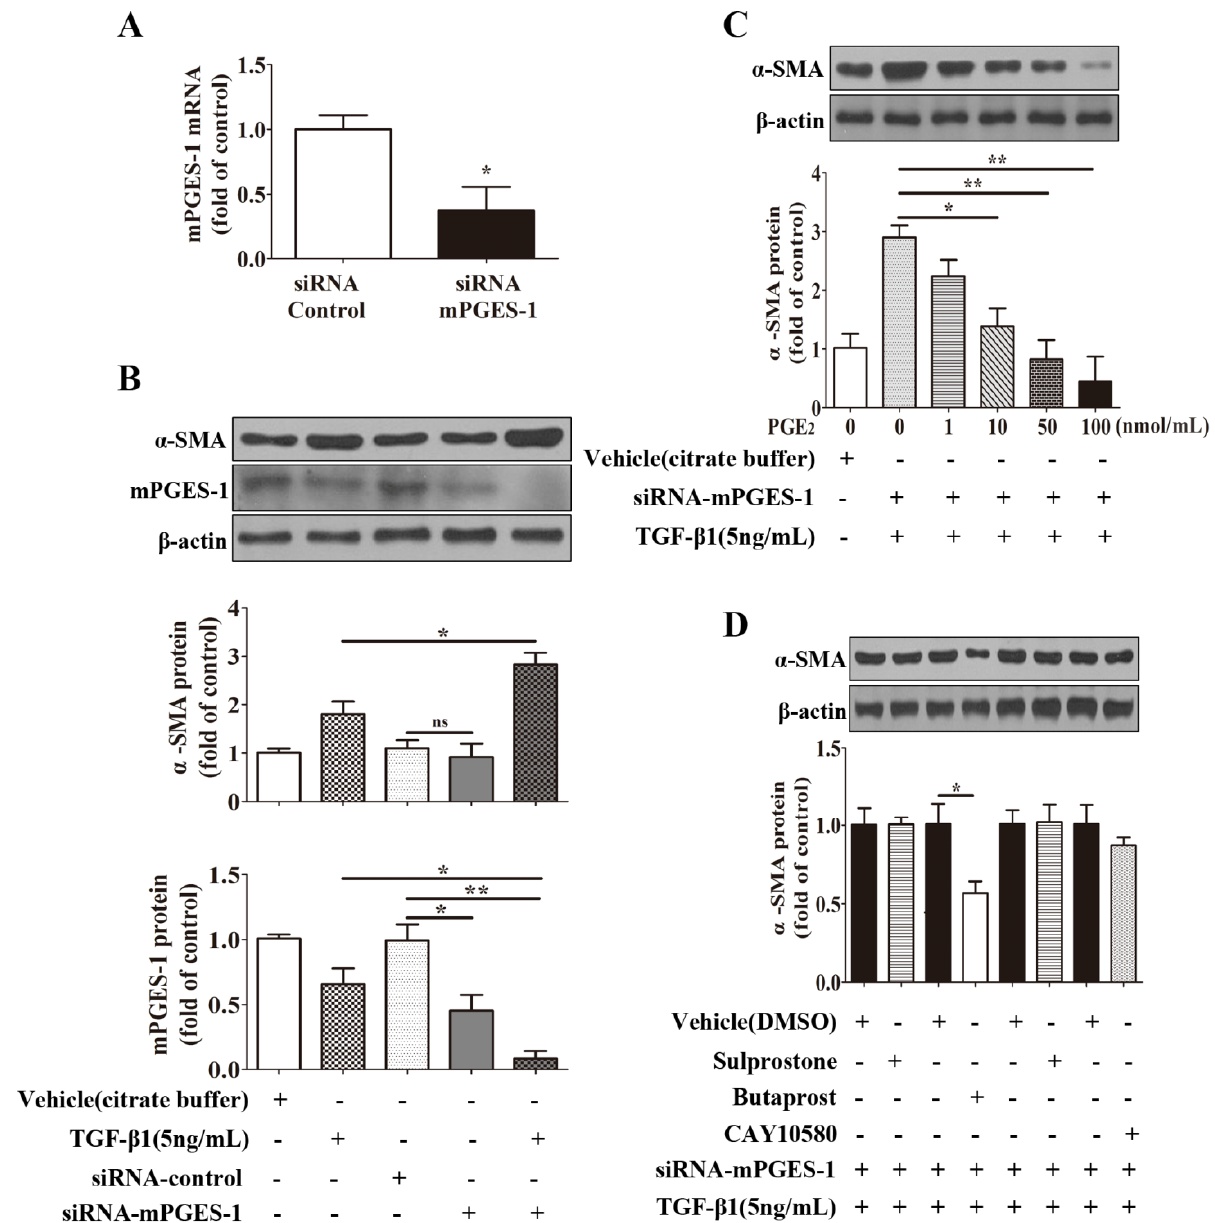
Figure 6. mPGES-1-derived PGE exerts a beneficial effect against α -SMA expression 2 induced by TGF- β 1 in MRC-5 cells via EP2 receptor-mediated signaling transduction. After starvation and siRNA transfection, the cells were co-incubated with TGF- β 1 and various concentrations of PGE (0, 1, 10, 50, 100 nmol/mL) for 24 hours or with TGF- β 1 2 and various EP agonists (sulprostone for EP1 and EP3, butaprost for EP2, and CAY10580 for EP4, 100 nmol/mL) for 24 h. ( A ) siRNA treatment on mPGES-1 mRNA level in MRC-5 cells; ( B ) Knockdown of mPGES-1 augmented TGF- β 1’s stimulatory effect on α -SMA protein expression; ( C ) PGE dose-dependently inhibited α -SMA protein expression 2 induced by TGF- β 1 in MRC-5 cells with mPGES-1 siRNA transfection; ( D ) Butaprost, EP2 agonist, decreased α -SMA protein expression induced by TGF- β 1 in MRC-5 cells with mPGES-1 siRNA transfection. Results are expressed as means ± SEM ( n = 3) ( * p < 0.05, ** p < 0.01, ns, not